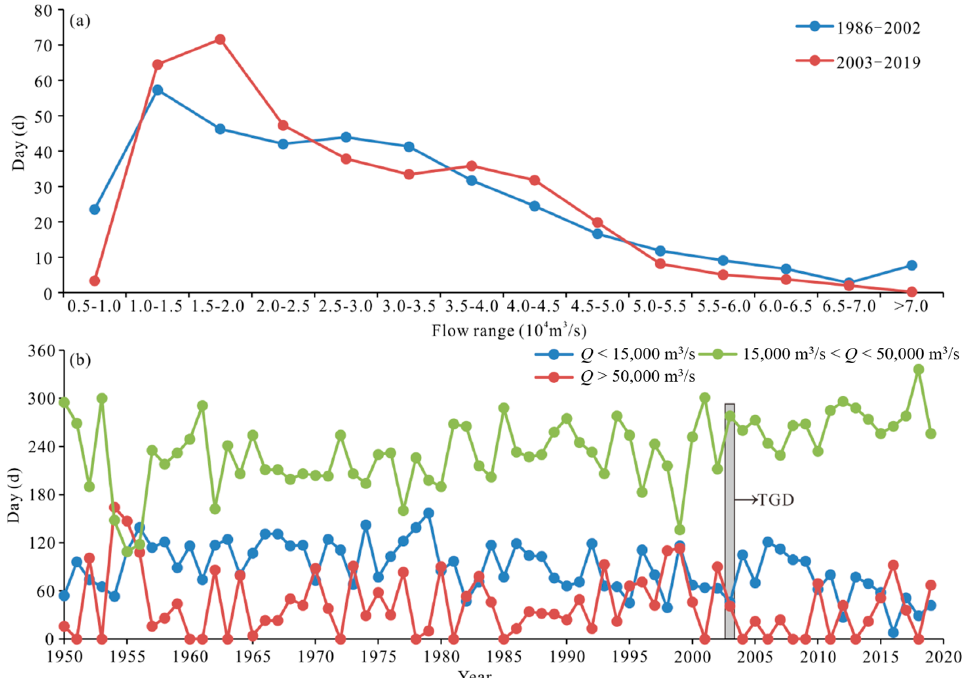
Figure 12. Variation in characteristic flow at Datong station. ( a ) Characteristic flow variation; ( b ) number of days with characteristic discharge.